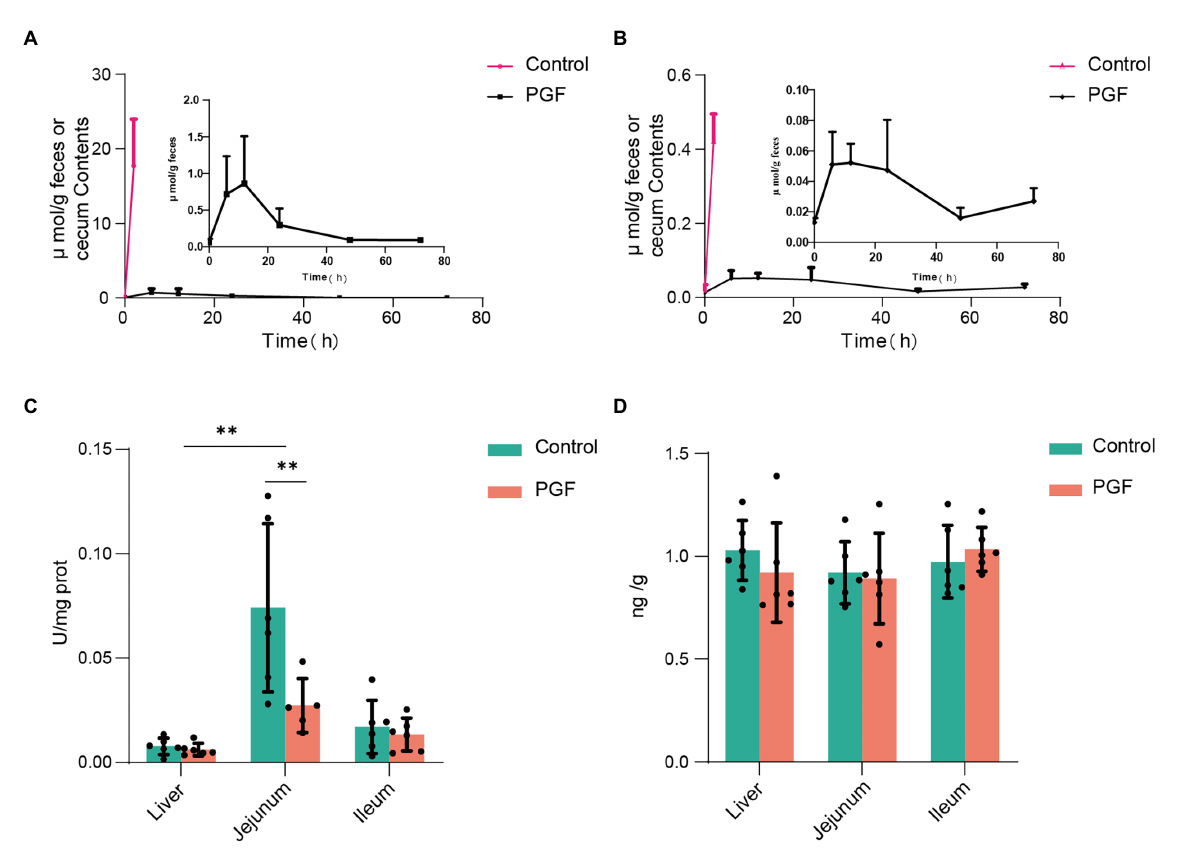
FIGURE 6 Fecal excretion of CN and SCN and the host CN and SCN metabolic enzyme activity ( n = 6). (A) CN and (B) SCN content in the caecum (for the control group) or feces (for the PGF group) over time; (C) Activity of β -glucosidase; (D) Expression of rhodanese in liver, jejunum, and ileum. * p < 0.05 and ** p <